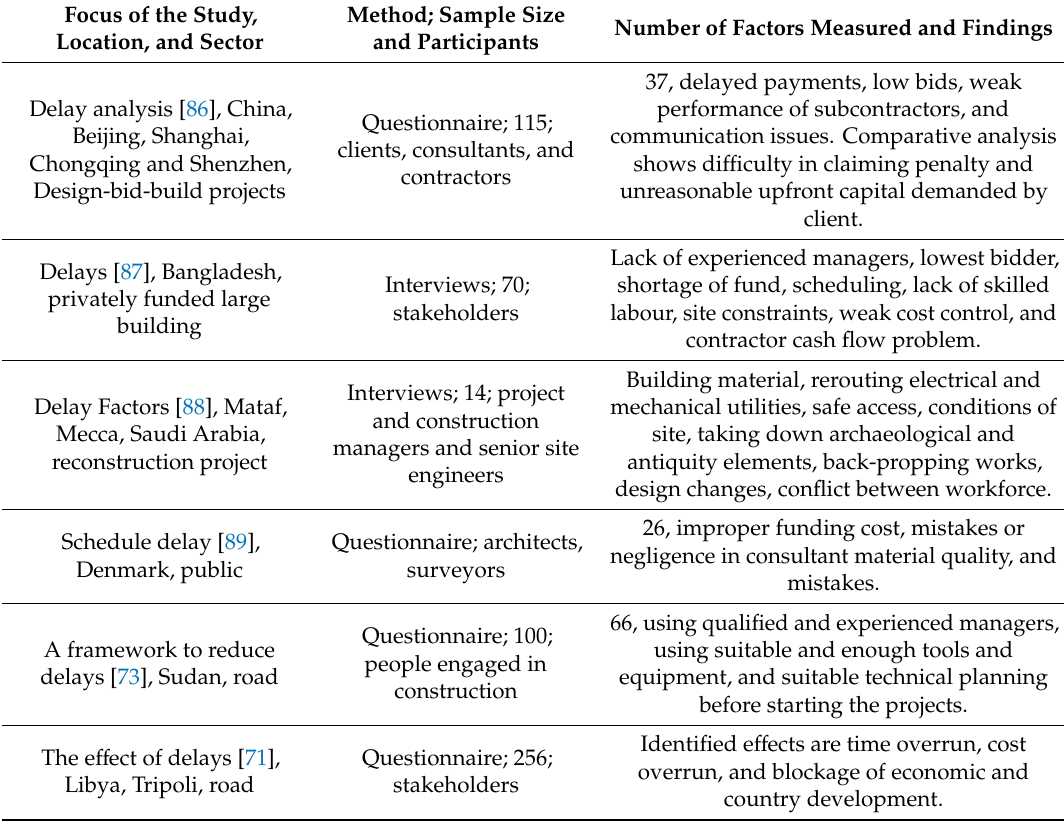
Table 4. Summary of selected articles of cluster 2 of delay investigations from 2015 to